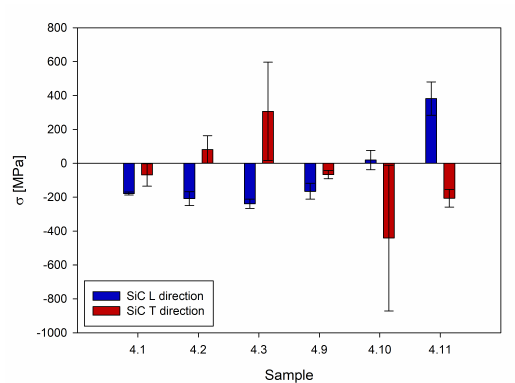
Figure 3. Values of macroscopic residual stresses after grinding by diamond disc (samples x.1-x.3) and AAT (samples x.9-x.11) of SiC.